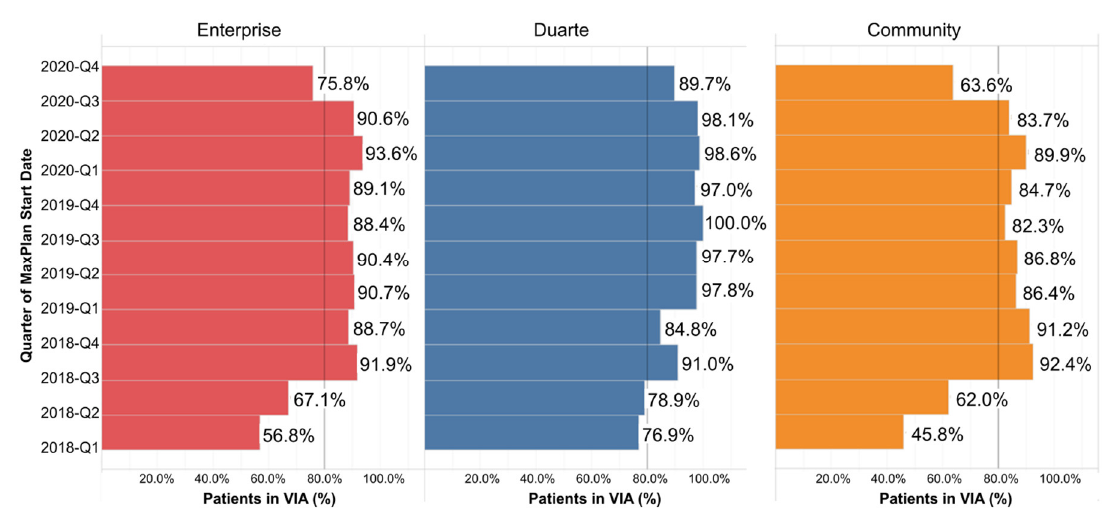
Figure 4. Percentage of new EPIC Beacon starts that were navigated in ClinPath by medical oncologists for solid tumors since go live for enterprise overall then by Duarte campus site and all community sites. Note Q3 data were incomplete at time of manuscript data collection in May 2020, so the final% of patients in Q3 who were navigated in ClinPath is likely higher, as is seen in other recent quarters.